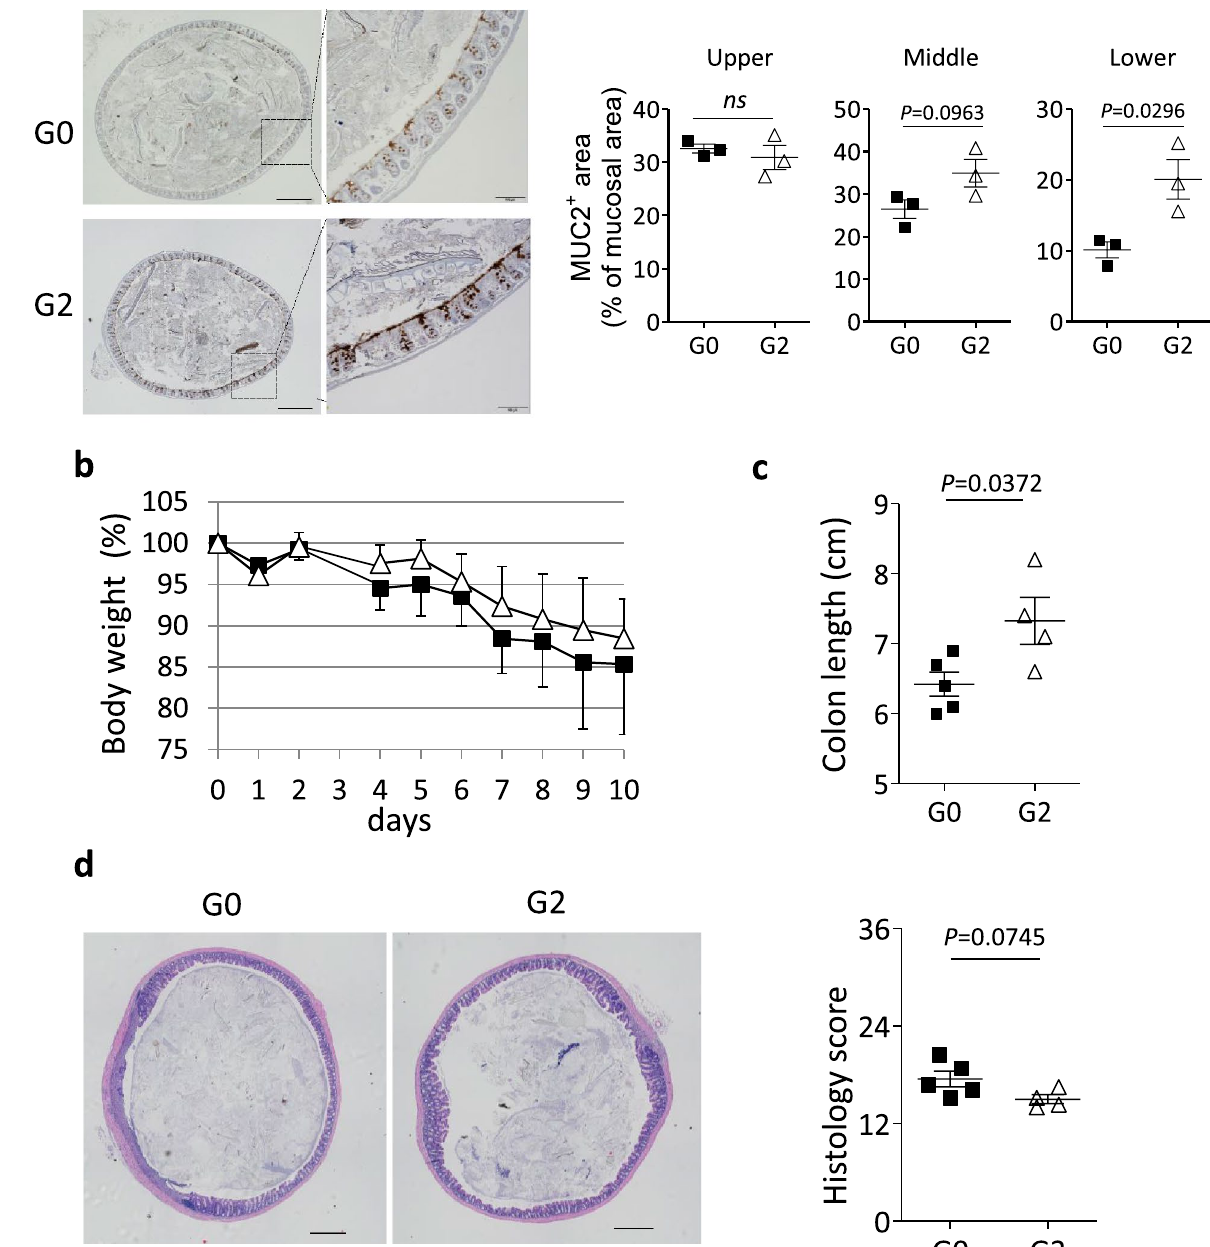
Figure 4. Enterococcus phage colonization potentially enforces colonic barrier function. The role of phiEG37k in gut homeostasis and inflammation was explored by analyzing the ASF-mice colonized with G0 or G2 . ( a ) Immunohistochemical analysis for MUC2 protein in the colonic tissue from ASF-mice colonized with G0 or G2 (n = 3 per each group). Representative images of lower colons from mice colonized with G0 or G2 (left panel). The percentage of MUC2-stained area in mucosal area (right panels) was quantitated by ImageJ software. Scale bars indicate 500 µm in left panels and 100 µm in right panels. ( b – d ) 2.5% of DSS was administered for 7 days to G0 - or G2 -colonized mice for colitis induction (n = 4–7 per each group). Two independent experiments were performed. ( b ) Body weight change during DSS colitis (n = 5 for G0 , n = 4 for G2 ). ( c ) Colon length on day 9 post-administration with DSS is shown. ( d ) Representative HE stained colonic tissue (left panels) and histology scores of colitis (right panel) from mice described in ( b ). Scale bars indicate 500 µm. Two-tailed unpaired t-test P values are presented. ns ; not significant. n = 3 in ( a ). n = 4–5 in ( c ) and ( d